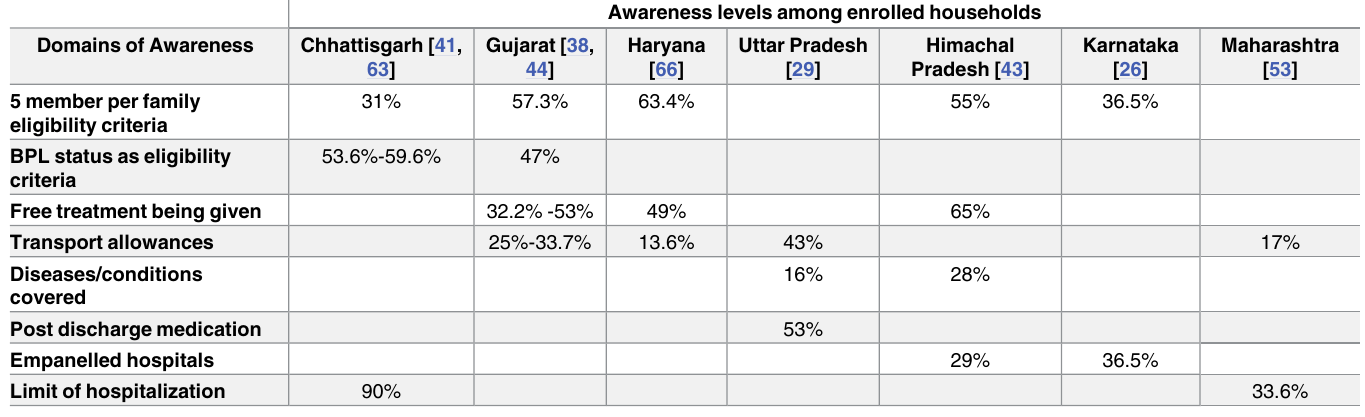
Table 3. Awarenessabout publicly sponsored health insurance schemes in Indian